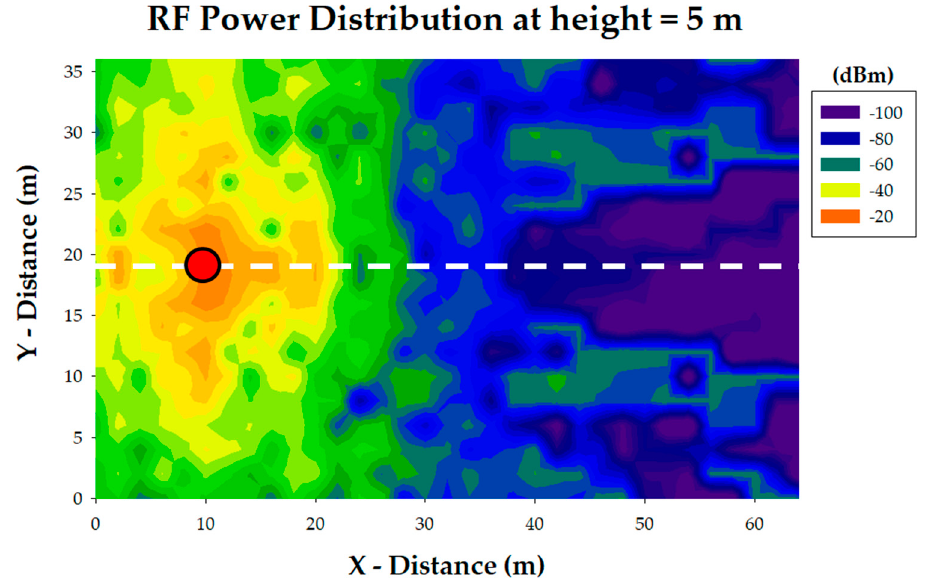
Figure 5. Estimated RF power distribution plane at height = 5 m for a wireless sensor on the orchard (represented by a red dot).